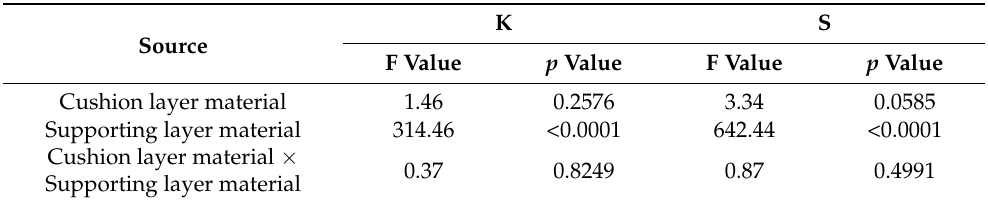
Figure 5. The mean hardness of the mattresses evaluated in this study (supporting layer). 3.2. Hardness Grade Analysis of variance (ANOVA) is a widely used technique for investigating the sig- nificance of input parameters and evaluating a model’s adequacy. The ANOVA results of 𝑃 (cid:3030) and 𝜂 are shown in Tables 2 and 3. The p -values of the quadratic models were less than 0.0001, indicating that these two models are extremely significant. For the same rea- son, all of the input parameters exhibited significant influence on 𝑃 (cid:3030) and 𝜂 , and many of